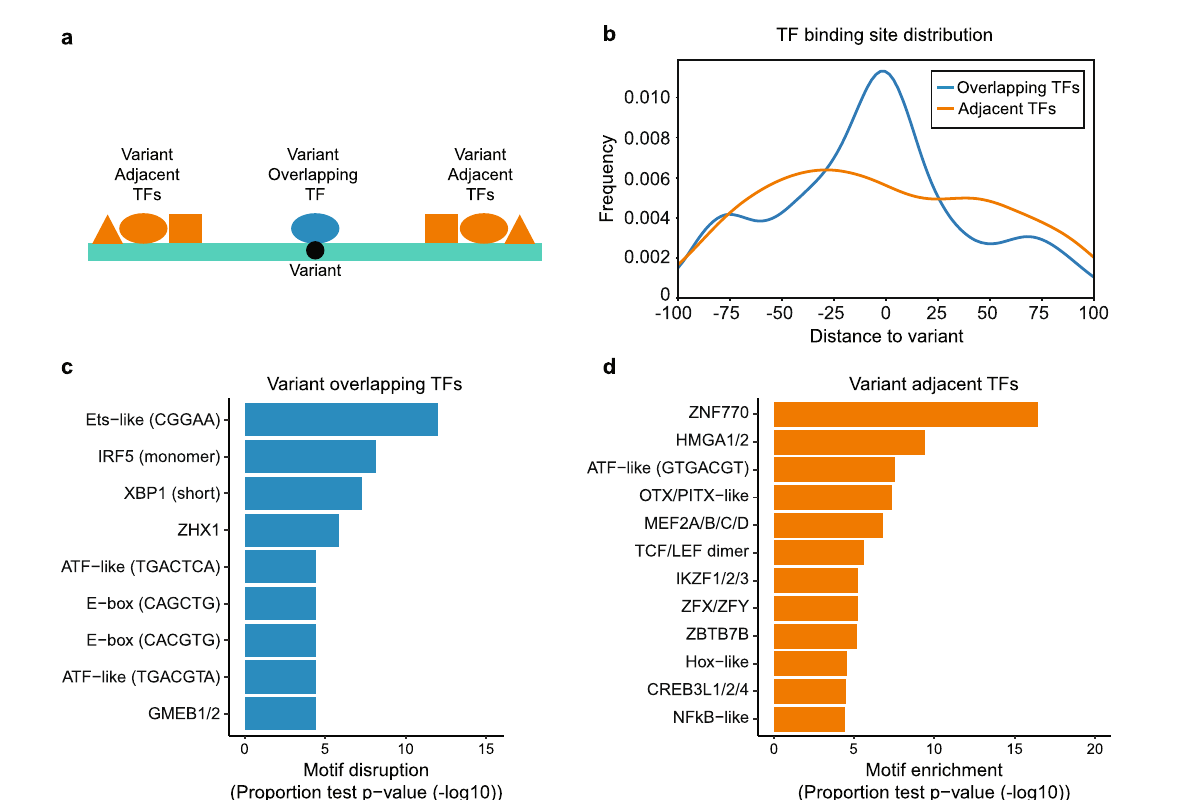
Fig. 5 Identi fi cation of variant overlapping and variant adjacent TFs. a Model of variant overlapping and variant adjacent transcription factors (TFs). Variant overlapping TFs (blue) allelically bind on top of variants, while variant adjacent TFs (orange) allelically bind near variants. b TF binding site location distribution for variant overlapping (blue) and variant adjacent (orange) TFs, relative to allelic enVars. c TF motif families enriched for participating as variant overlapping TFs at allelic enVars. Motif disruption p -values were estimated by a two-sided proportions test by comparing the fraction of motif disruption events at allelic enVars to the fraction observed at non-allelic enVars (see “ Methods ” ). d TF motif families enriched for participating as variant adjacent TFs at allelic enVars. Motif enrichment p -values were estimated by a two-sided proportions test by comparing the fraction of predicted TF binding sites in allelic enVars to random expectation (see “ Methods ” ). For both the variant overlapping and variant adjacent analyses, motif families are shown with p fi ve or more predicted binding sites at allelic enVar loci, adj < 0.0001 and three or more allelic events at allelic enVar loci, or